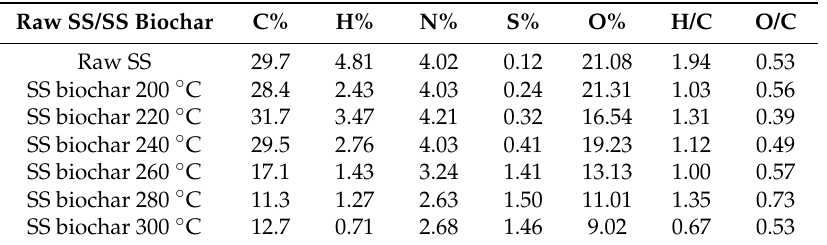
Elemental analysis of raw sewage sludge and torrefied sewage sludge biochars at different